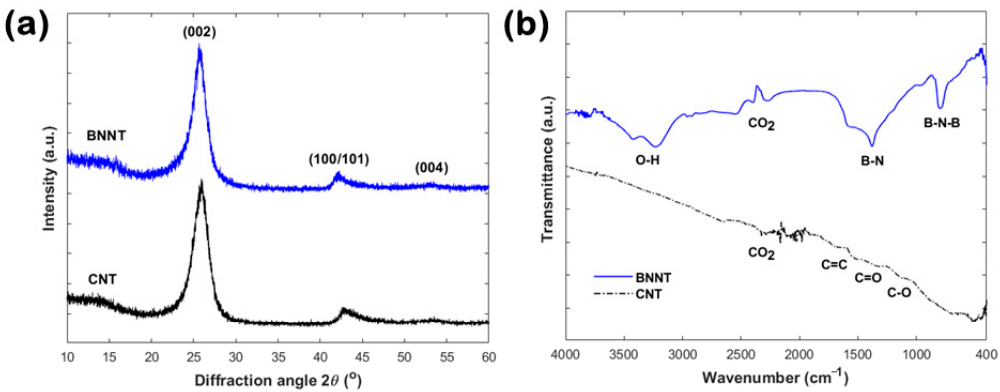
Figure 5. ( a ) X-ray di ff ractograms and ( b ) FT-IR spectra for the BNNTs and